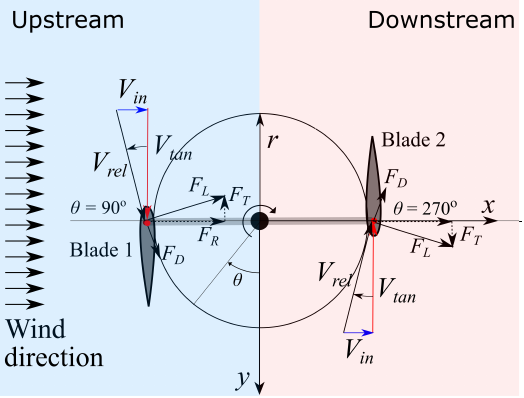
Figure 5. Schematic diagram of a cross-section of a two-bladed